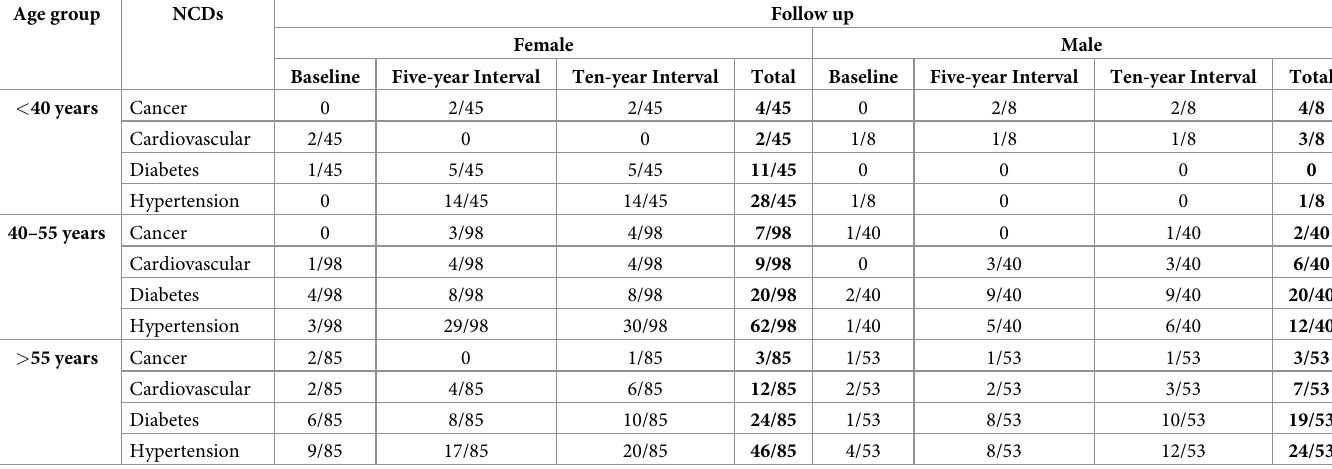
Table 1. Analysis of NCDs’ incidence based on gender and